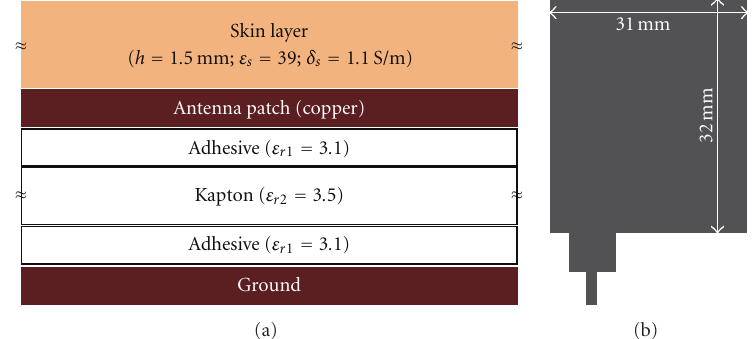
Figure 1: Schematics of (a) antenna-skin stack and (b) optimized antenna showing the matching stub at the input port (antenna dimensions: patch length: 32 mm; patch width: 31 mm).